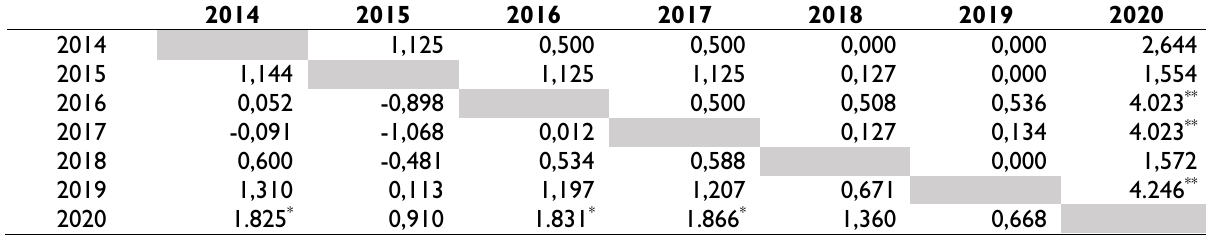
Table 3. Test of Similarity of Distribution and Equality of Median b of the FRQ for Two Distinct